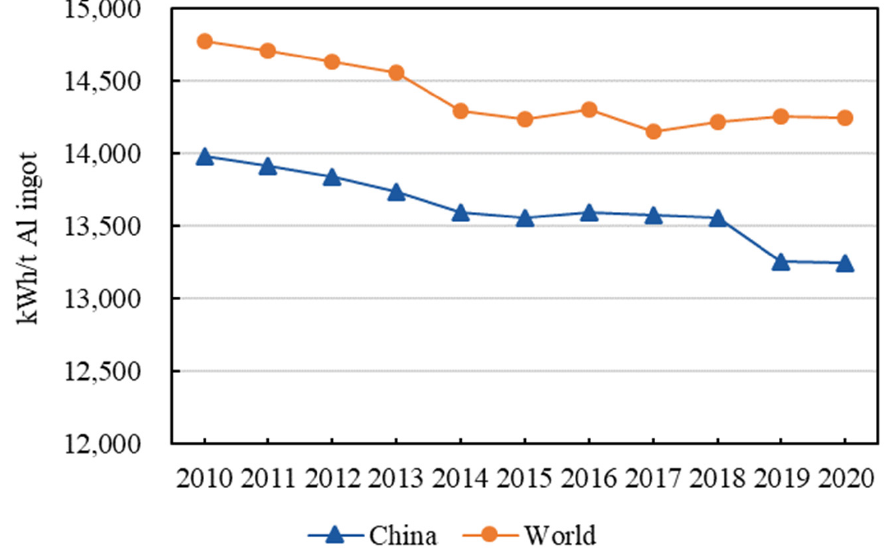
Figure 5. Overall electricity consumption per ton of primary aluminum ingot 16.